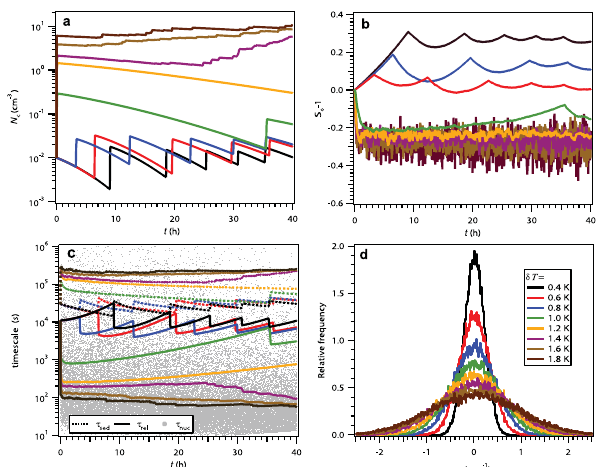
Fig. 4. Evolution of a cirrus cloud under pure homogeneous freez- ing, lifting at 1cms − 1 with initial T = 195K and cloud thickness, H = 500m, and α d = 1. Shown are (a) the ice crystal number con- centration, (b) mean supersaturation, (c) characteristic timescales of freezing (gray dots), relaxation (solid lines), and sedimentation (dotted lines), and, (d) frequency distribution of vertical velocity, for different values of the mean amplitude temperature fluctuations, δT